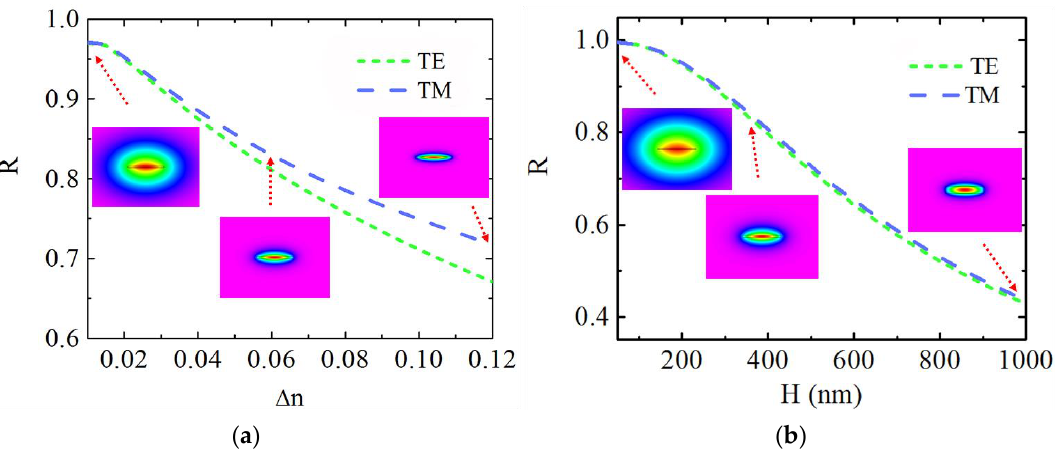
Figure 2. The evanescent field ratio R as functions of ( a ) ∆ n at H = 250 nm and ( b ) H at ∆ n = 0.03 for TE and TM fundamental modes. Insets: TM fundamental mode fields when ( a ) ∆ n = 0.01, 0.06, 0.12 and ( b ) H = 50 nm, 350 nm, 1000 nm, respectively.